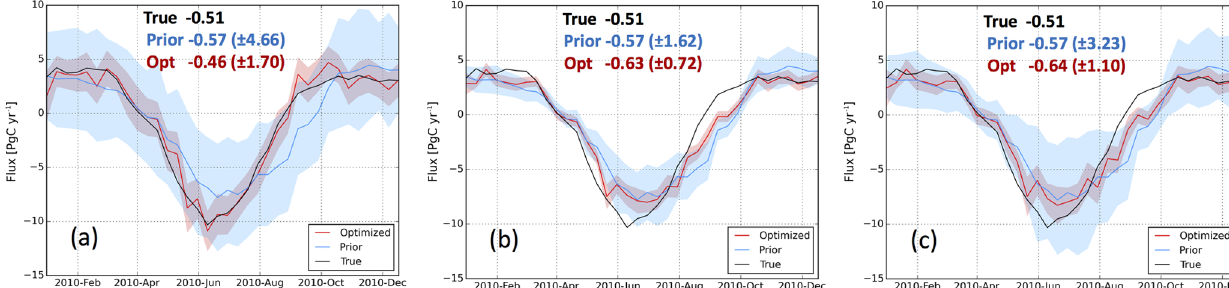
Figure 9. Comparison of the performance of inversions with pseudo-data using the two flux optimization methods: (a) the additive method and (b) the multiplicative method, (c) is similar to (b) but with 2 times the flux uncertainty, i.e., setting the biosphere scaling parameter variance to 160%. The “truth” fluxes are generated in a forward simulation using biosphere fluxes from SiBCASA. The same SiB3 fluxes are used as a priori for all runs. The annual net biosphere fluxes of the truth, prior, and optimized are given in the legend, with the unit of PgCyr − 1 .